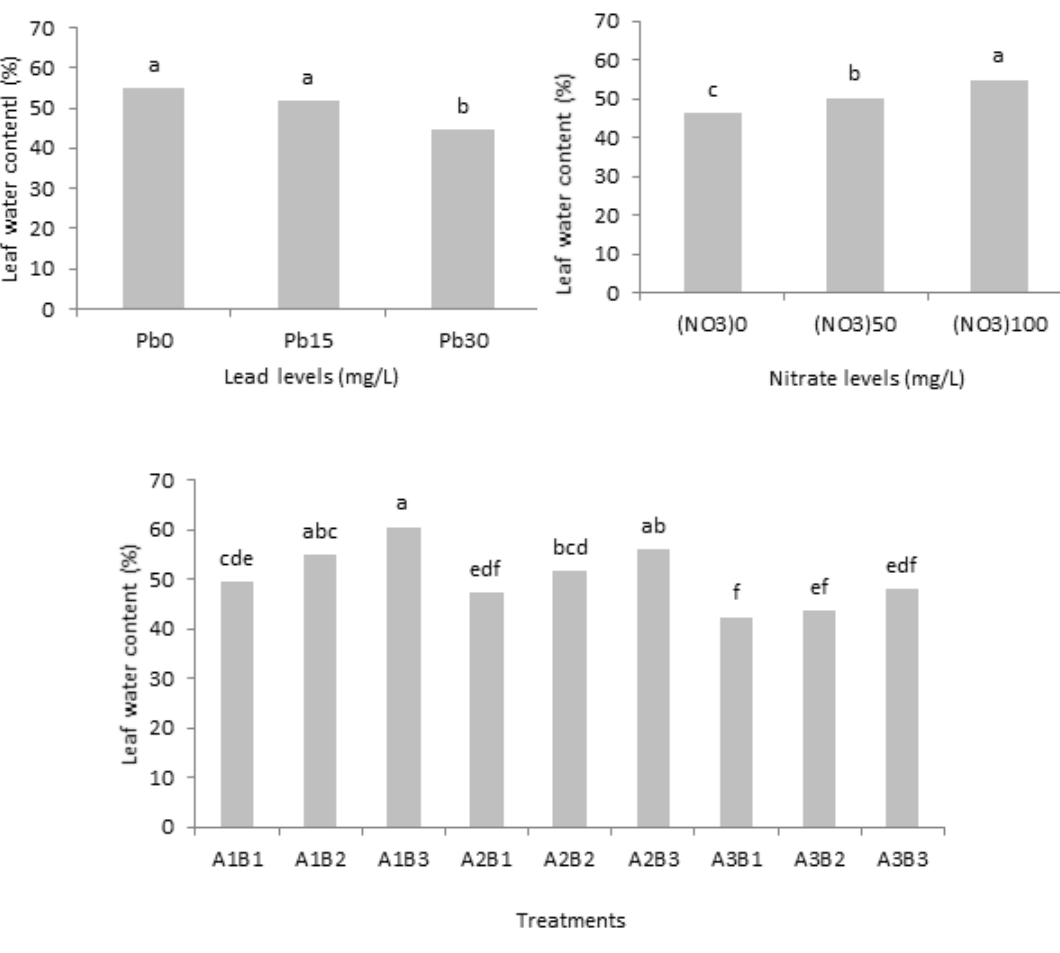
Figure 5: Leaf water content of Judas tree plants under long term (two years) lead and nitrate interaction treatments. Treatments indicate lead levels (A: 0, 15, 30 mgL -1 ) and nitrate levels (B: 0, 50, 100 mgL -1 ). Data are average of four replications ±SD. Comparison of means was done at 5% level of LSD